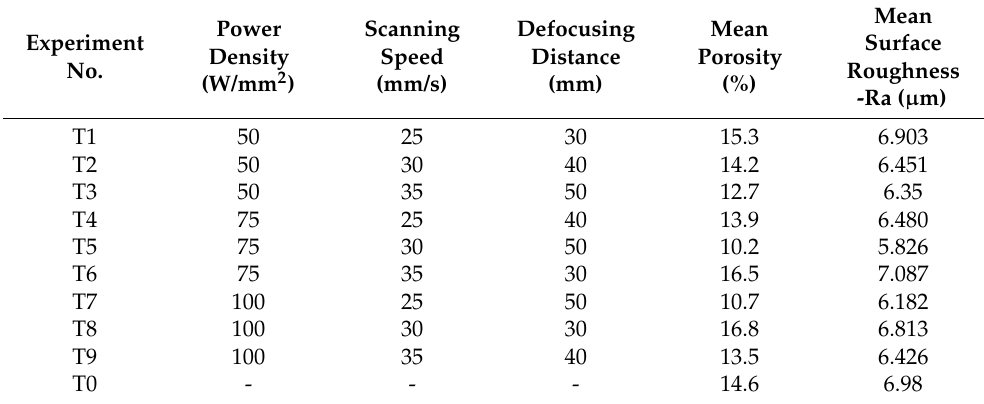
Table 2. Experimental layout of laser micromelting